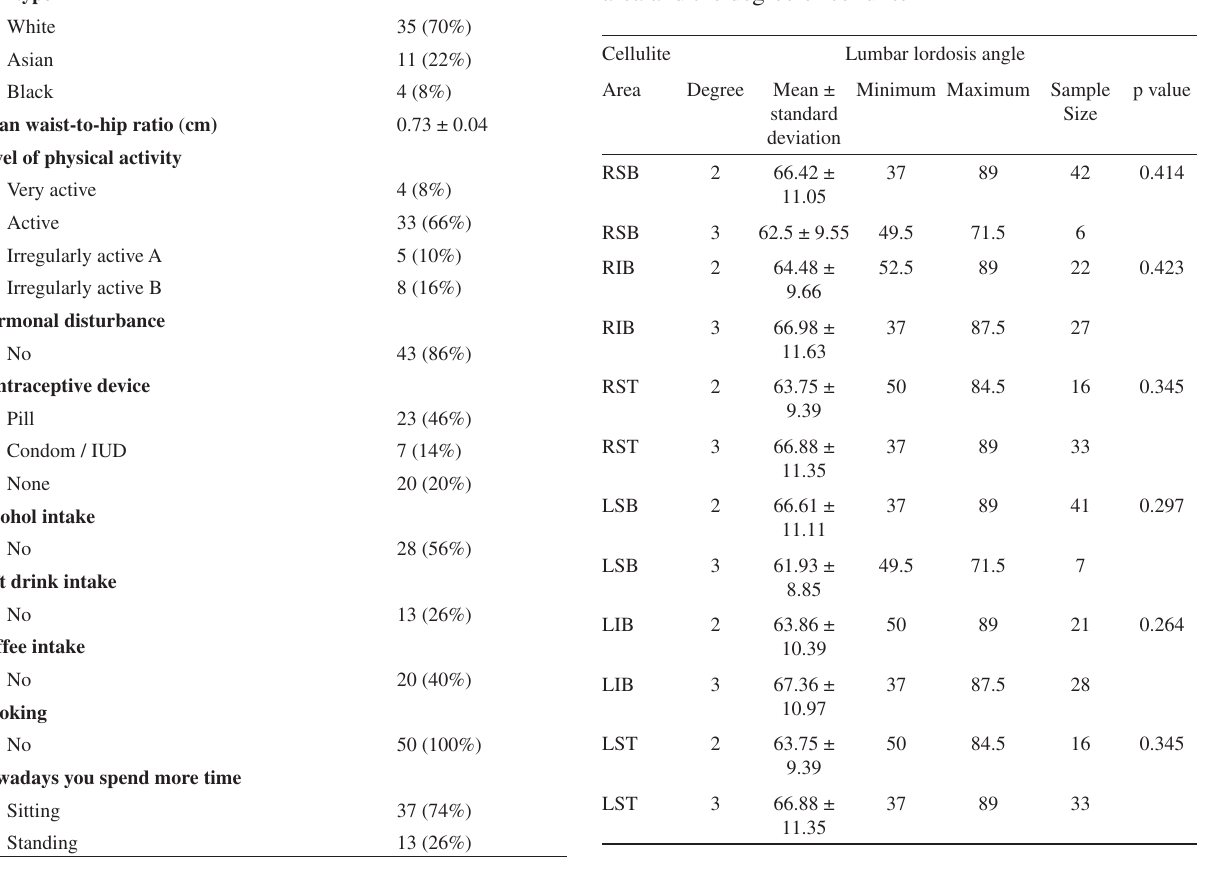
Table 3 - Mean lumbar lordosis angle. Standard deviation and p values obtained using ANOVA according to the assessed area and the degree of cellulite